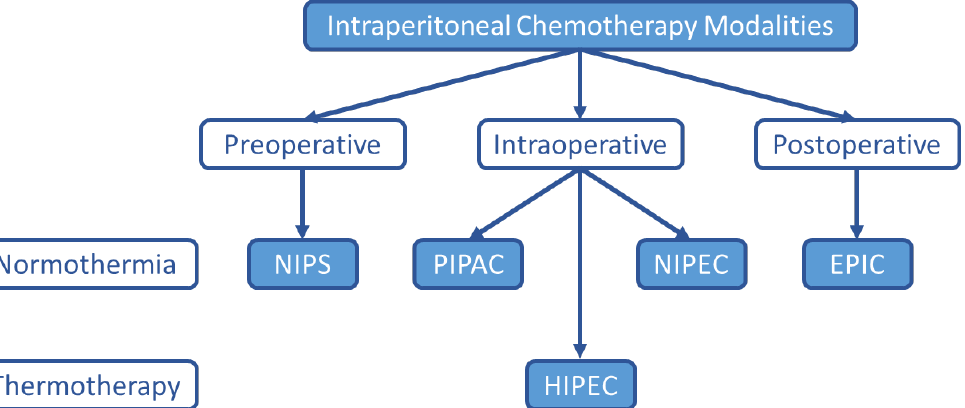
Figure 1. Alternate Intraperitoneal Chemotherapy Treatment Modalities. Although HIPEC is the current standard-of-care intraperitoneal chemotherapy treatment option for PC from appendiceal and colorectal malignancies, other intraperitoneal chemotherapy treatment strategies are under investigation. NIPS (neoadjuvant intraperitoneal and systemic chemotherapy), PIPAC (pressurized intraperitoneal aerosol chemotherapy), HIPEC (hyperthermic intraperitoneal chemotherapy), NIPEC (normothermic intraperitoneal chemotherapy), EPIC (early postoperative intraperitoneal